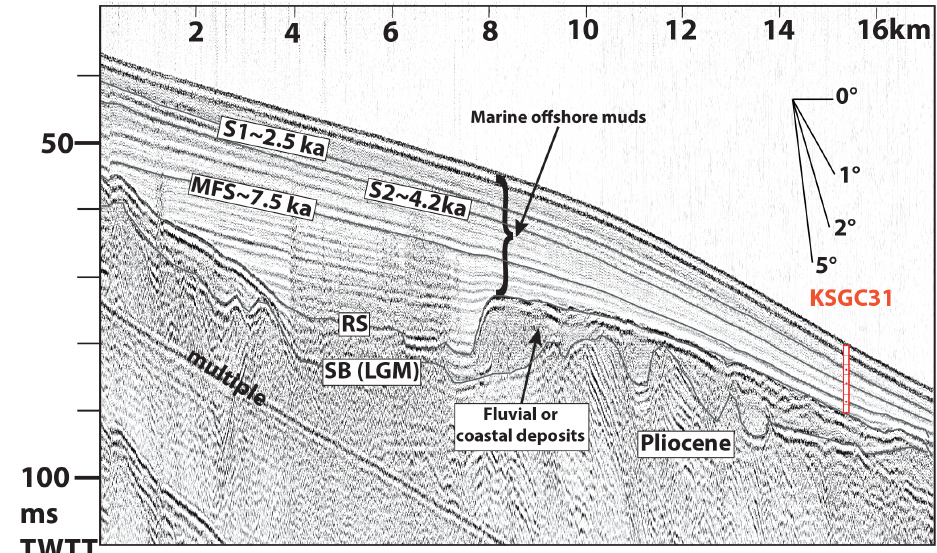
Figure 2. Seismic profile across the Rhône mud belt at the position of core KSGC31 (position in Fig. 1). SB: sequence boundary surface formed by continental erosion during the Last Glacial Maximum (LGM). RS: ravinement surface formed by wave erosion during sea-level rise. It corresponds to the coarse interval at the base of the core. MFS: maximum flooding surface. It corresponds to the phase of transition between coastal retrogradation and coastal progradation. It is dated here to ca. 7.5kacalBP (i.e. the period of global sea-level stabilization). S1 and S2 are seismic surfaces used as time lines on the basis of the age model in Fig. 3 (respectively 4.2 ± 0.5 and 2.5 ± 0.5kacalBP). Horizontal bars every meter along the core. Vertical scale in milliseconds two-way travel time (ms TWTT).